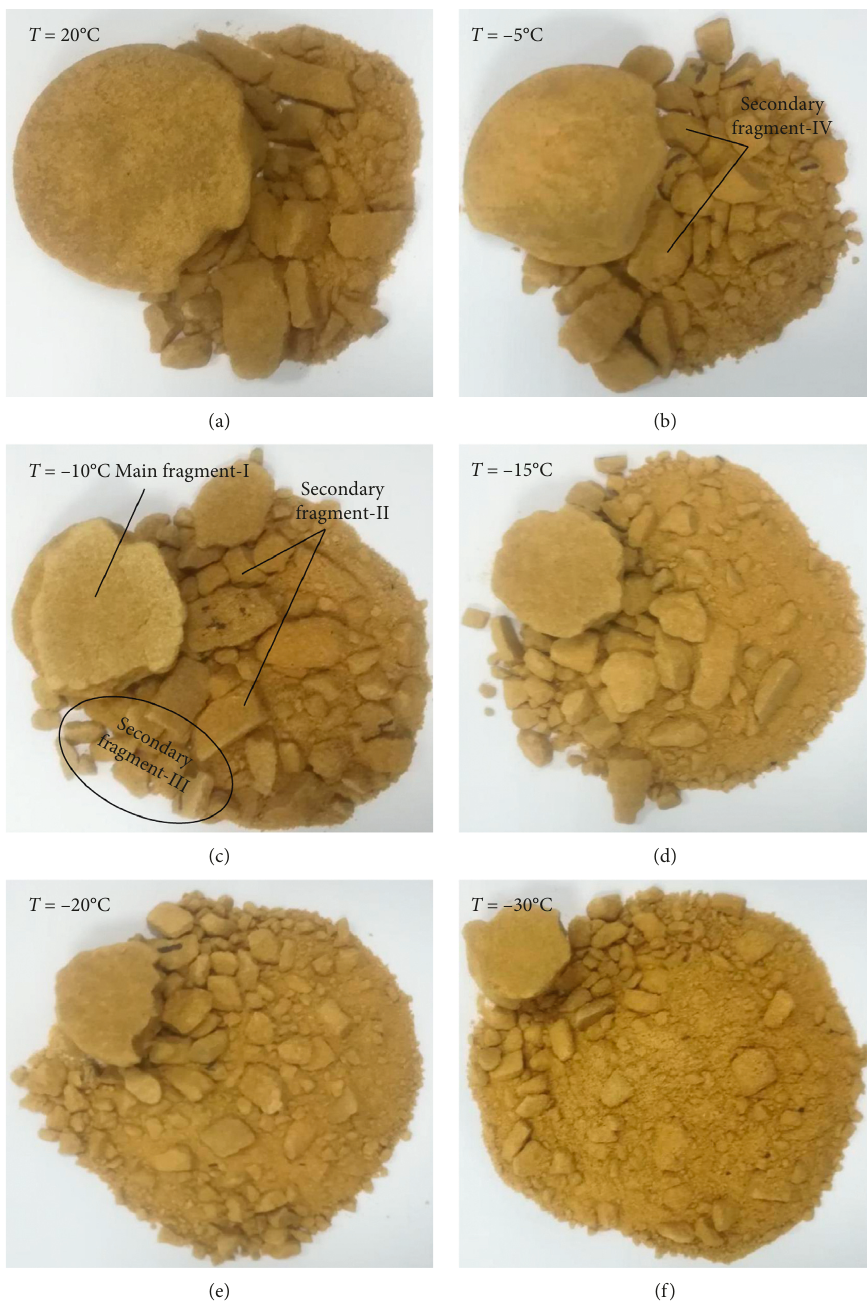
Figure 13: Typical lumpiness distribution characteristic of yellow sandstone under different F-T temperatures.